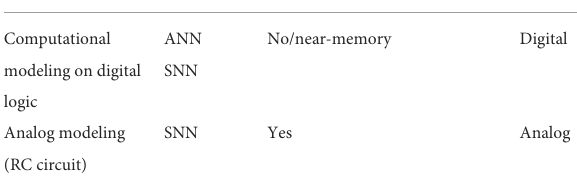
TABLE 2 A comparison of neuromorphic approaches to neuron soma